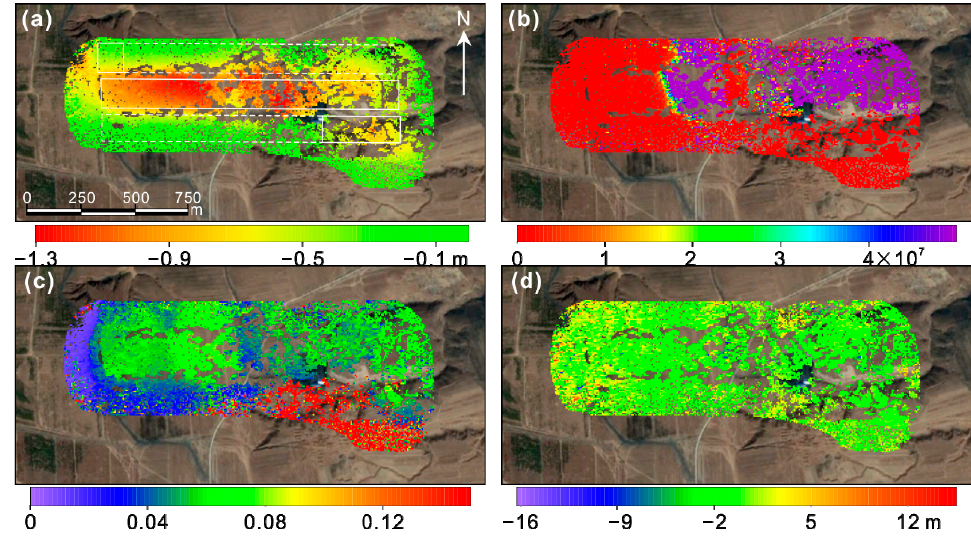
W , a and b of the logistic model; ( d ) Estimated 0